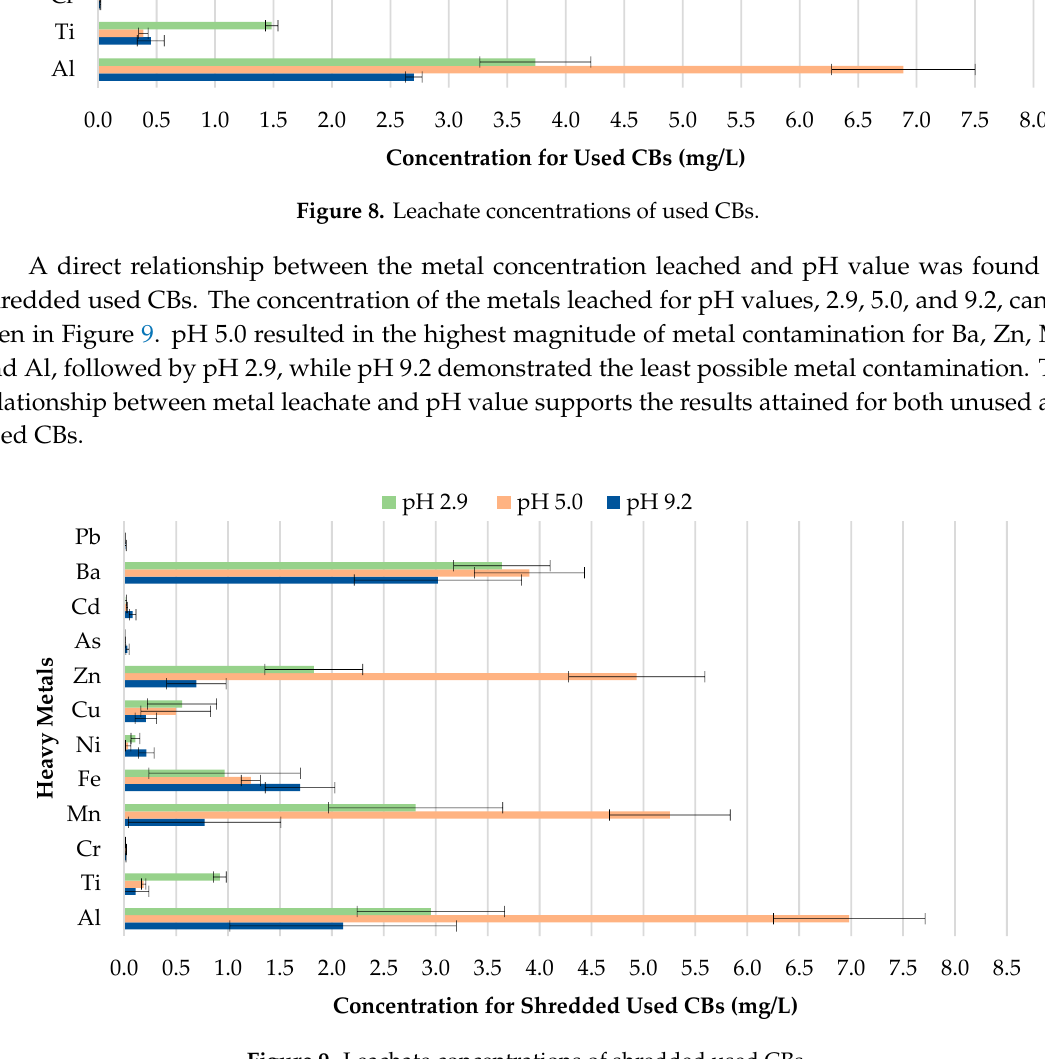
Figure 9. Leachate concentrations of shredded used CBs.